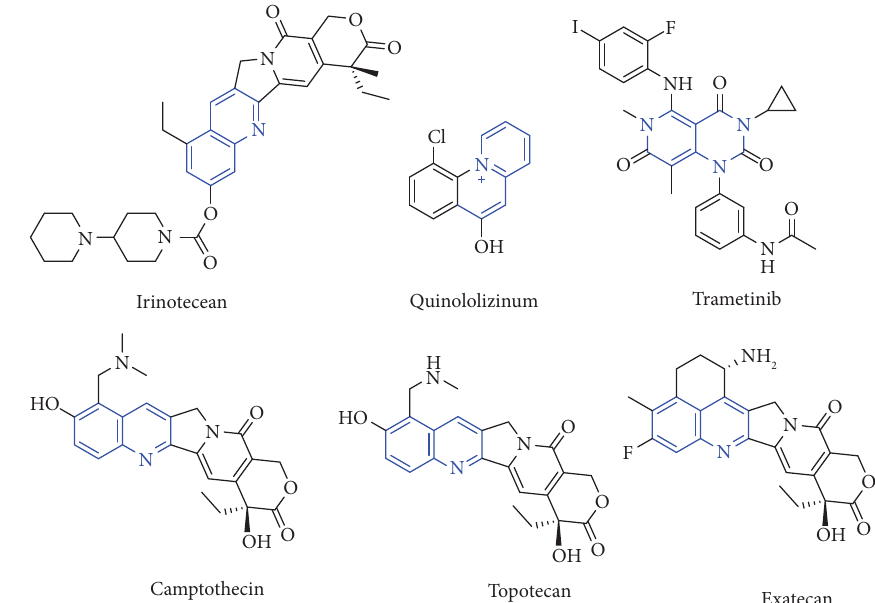
Figure 1: Some quinoline based anticancer drug molecules.